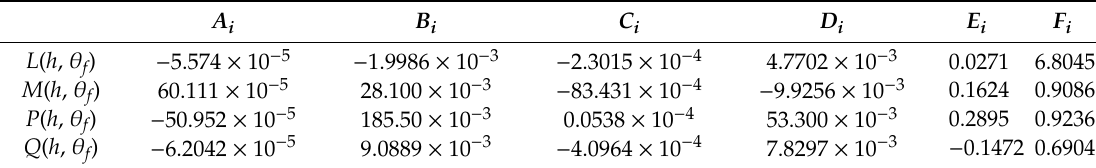
Table 2. Coe ffi cients of the polynomial functions [1]. Table 2. Coefficients of the polynomial functions [1].